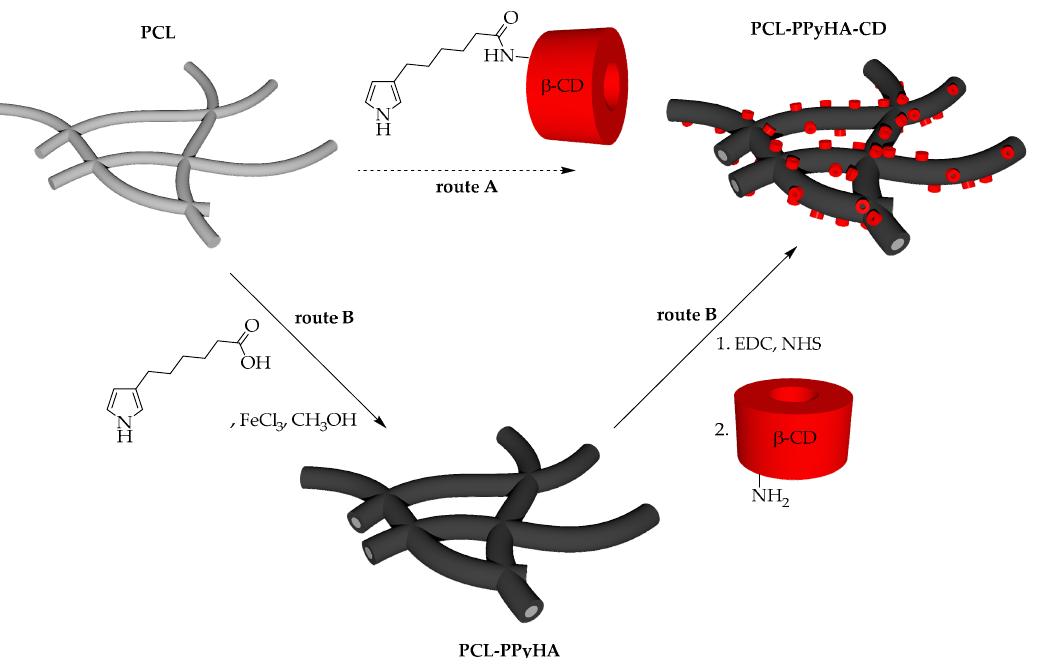
Figure 1. General routes for the preparation of poly [6-(pyrrol-3-yl)hexanoic acid]-cyclodextrins (PPyHA-CD) modified polycaprolactone (PCL) scaffolds. ( Route A ) direct polymerisation of pyrrole-CD conjugate onto PCL fibres. ( Route B ) stepwise functionalisation—polymerisation of 6-(pyrrol-3-yl)hexanoic acid and subsequent coupling with amino derivative of β -cyclodextrin ( β -CD). Image not to scale.